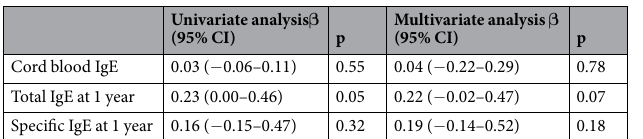
Multivariate analysis β (95% CI)